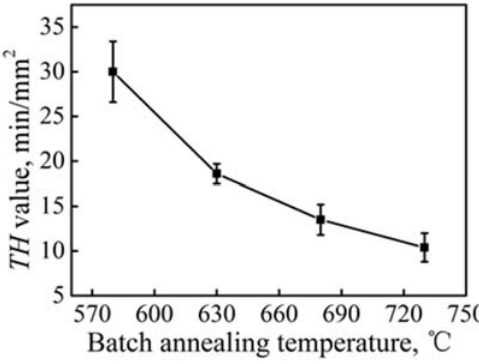
Figure 9. Effect of the batch annealing temperature on the TH value of ultra ‐ low carbon enamel steel.